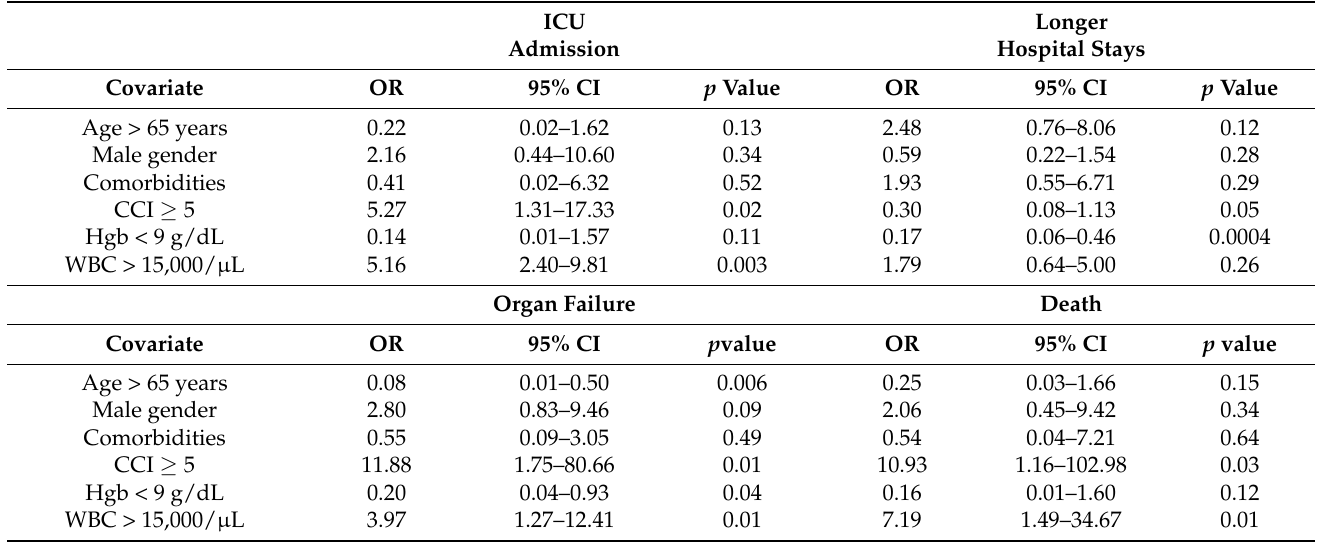
Table 6. Multivariate analysis of risk factors for poor prognosis in CDI alone group.